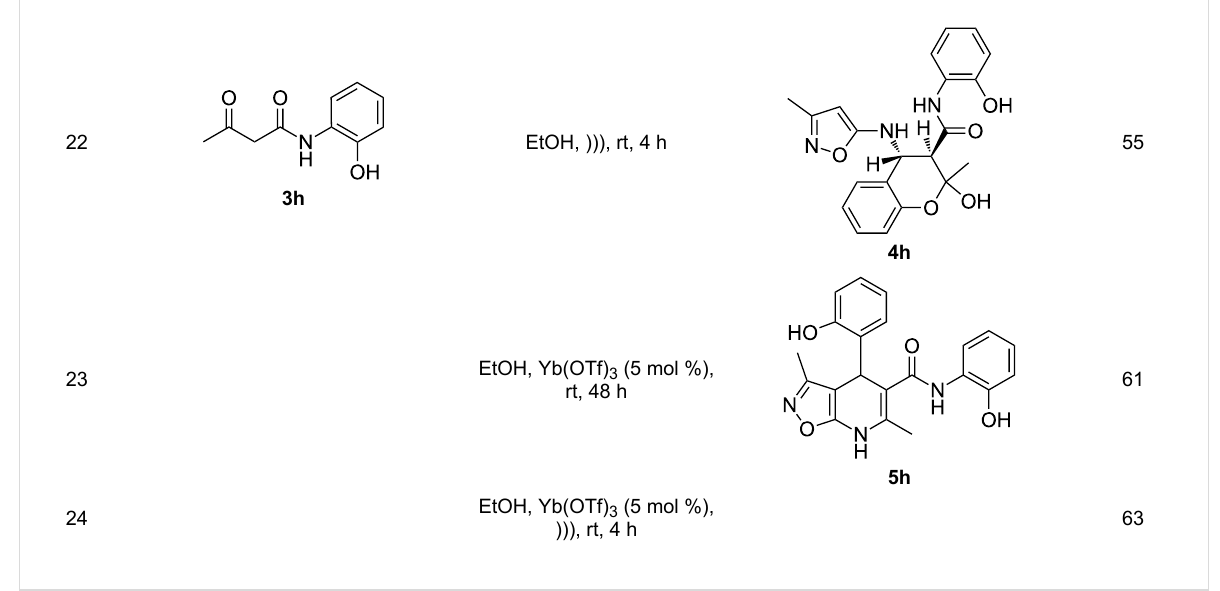
Table 3: Three-component heterocyclization of 5-amino-3-methylisoxazole ( 1 ), salicylaldehyde ( 2 ) and N -aryl-3-oxobutanamides ( 3a – h ).